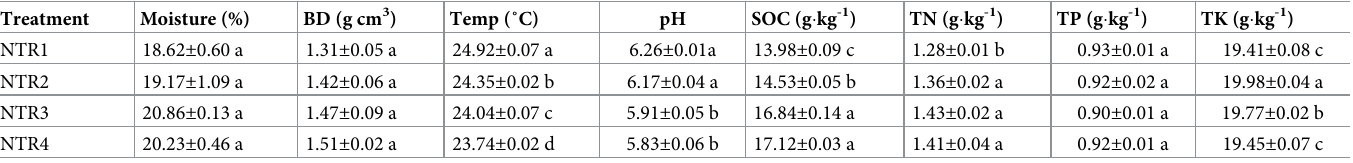
BD, soil bulk density; SOC, soil organic carbon; TN, total nitrogen; TP, total phosphorus; TK, total potassium; NTR1, no tillage and all crop residue removed; NTR2, no tillage and 30% crop residue mulching; NTR3, no tillage and 60% crop residue mulching; NTR4, no tillage and all crop residue mulching. Values are shown as means ± SD of three biological replicates. Different letters indicate significant differences (ANOVA, P < 0.05, Tukey’s HSD post-hoc